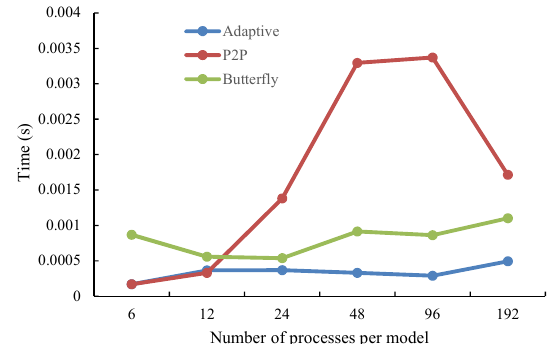
Figure 20. Average execution time ( y axis) of one data transfer be- tween the atmosphere model GAMIL2 and the land surface model CLM3 in GAMIL2–CLM3 when varying the number of processes per model ( x axis): 14 coupling fields on the GAMIL2 horizontal grid (the grid size is 128 × 60 = 7680) are transferred from the land surface model CLM3 to the atmosphere model GAMIL2.